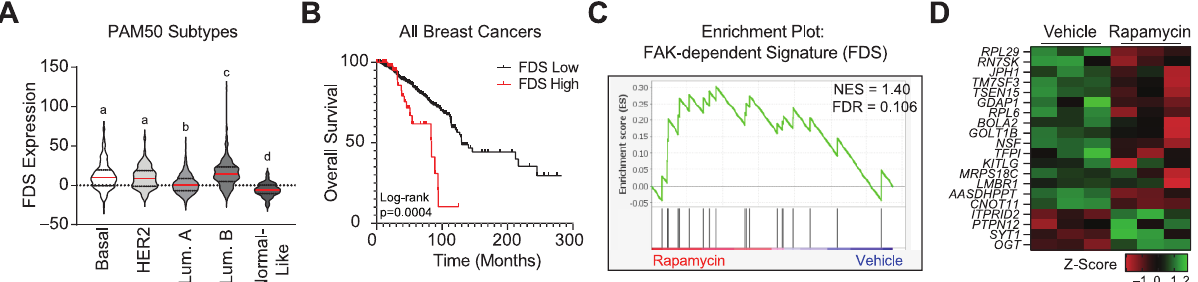
Figure 4. Pharmacologically inhibiting mTORC1 activity leads to the increased expression of a FAK signature gene set. ( A ) Analysis of FDS expression in breast cancer subtypes using data from the TCGA Pan-Cancer Atlas. Groups with the same letter are not statistically different; groups with different letters have a p -value < 0.05. Red lines represent medians. Dashed lines within the violin plots represent quartiles. ( B ) Kaplan–Meier plots of the overall survival of breast cancer patients whose tumors had high (top 5%, n = 54) or low (bottom 95%, n = 1028) expression of the FDS. Data were obtained from the TCGA Pan-Cancer Atlas. Log-rank test, p < 0.05. ( C ) GSEA plot and ( D ) heatmap of genes in FDS evaluated in RNA-seq data from MDA-MB-231 orthotopic xenografts treated with vehicle or rapamycin for three